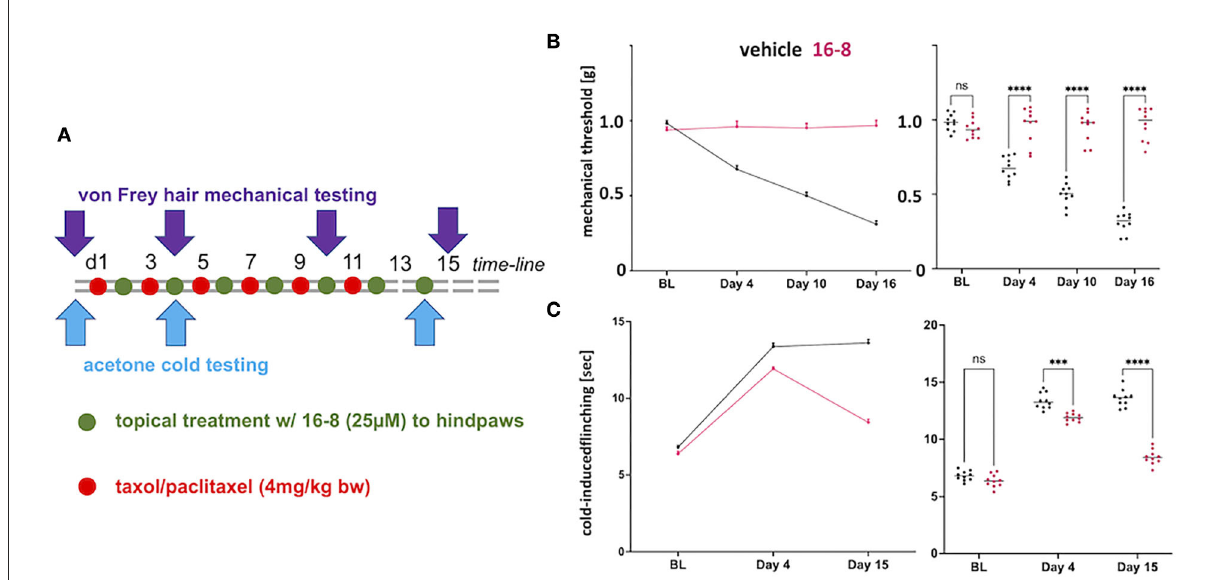
FIGURE1 Topical application of compound 16-8 is effective against Taxol-induced nerve pain in mice. (A) Shows a schematic illustration of the time-line of the experiment. Red dots stand for i.p injection of Taxol (4 mg/kg), green dots for topical application, to hindpaw skin, of compound 16-8 (25 µ M in 50 µ L formulation), controls received formulation vehicle only. (B) Show the complete protection of development of mechanical allodynia as an effect of topical treatment with compound 16-8. Left-hand line diagram shows time course of average mechanical threshold, as measured using automatic von-Frey-hair testing. Note sensitization in formulation vehicle-treated mice in terms of development of mechanical allodynia. In contrast, mice remained completely normally sensitive when treated with compound 16-8. Purple - compound 16-8-treated, black - formulation vehicle control-treated, upward error bar representing SEM. Right-hand data-cloud diagram show individual data points per mouse, n = 10 mice were used per group; note statistically significant difference between compound 16-8-treated (purple) vs. formulation vehicle controls (black), **** p < 0.0001 two-way ANOVA, Sidak’s multiple comparison test; lines represent group mean. (C) Show the protective effects of topical treatment with compound 16-8 on development of cold allodynia. Diagrams prepared as for (B) , with y-axis measurement of cold-avoidance nocifensive behavior. *** p < 0.001, **** p < 0.0001 two-way ANOVA, Sidak’s multiple comparison